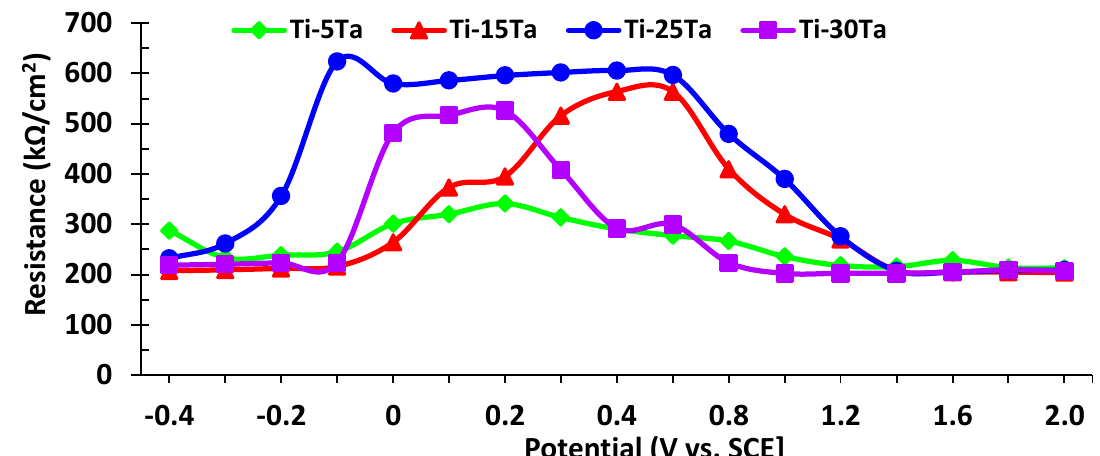
Figure 12. Resistance of the passive films for Ti–Ta alloys in Ringer’s solution.